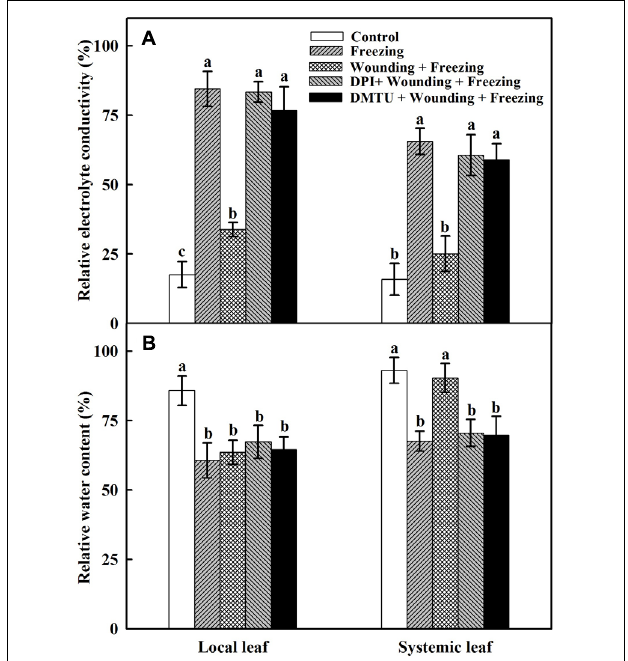
FIGURE 1 | Effects of mechanical wounding on relative electrolytic conductivity (REC) and relative water content (RWC) in the local and the systemic leaves of wheat under freezing stress. REC (A) and RWC (B) . The local (fifth) leaves were separately pre-treated with distilled water, 5 mM DMTU or 100 µ M DPI prior to wounding. At 10 days after wounding, the seedlings were exposed to freezing stress for 24 h. After 24 h recovery, REC and RWC were analyzed immediately on both local and systemic (sixth) leaves. Data are mean values ± SD of three independent replicates. Means denoted by different letters indicated significant difference at P < 0.05 according to Tukey’s